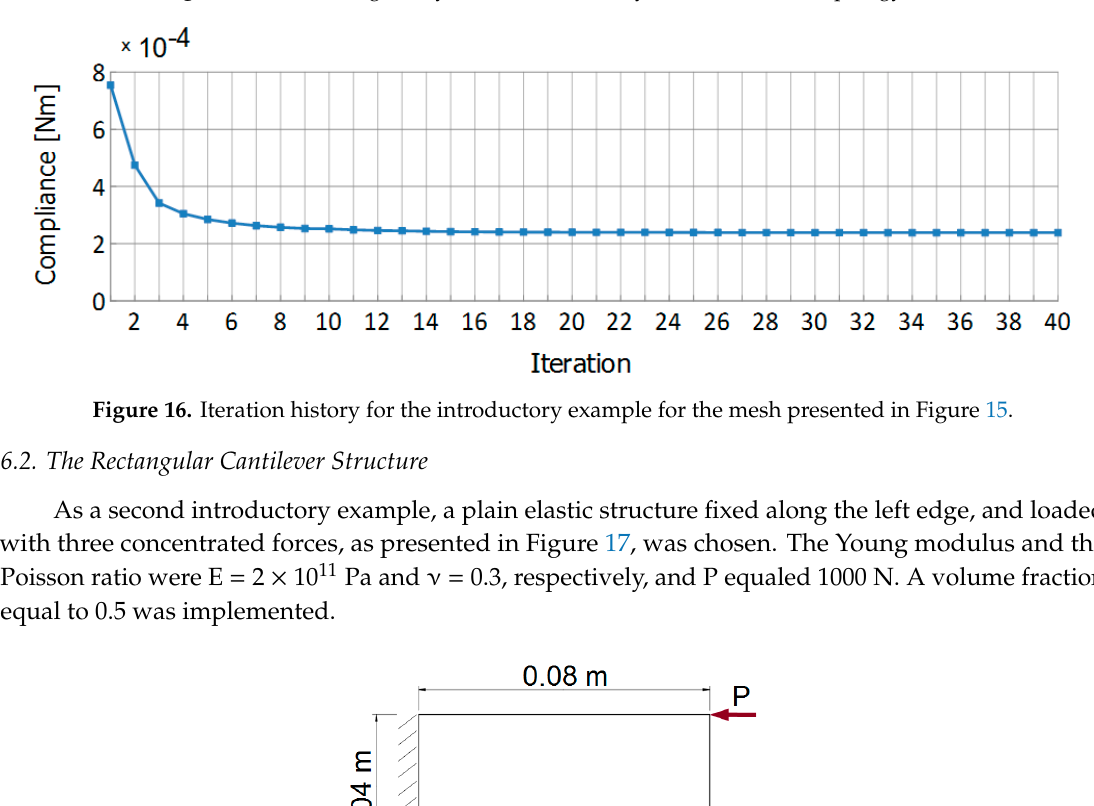
Figure 15. Initial irregularity of the mesh density ( a ) and the final topology ( b ). Appl. Sci. 2020 , 10 , x FOR PEER REVIEW